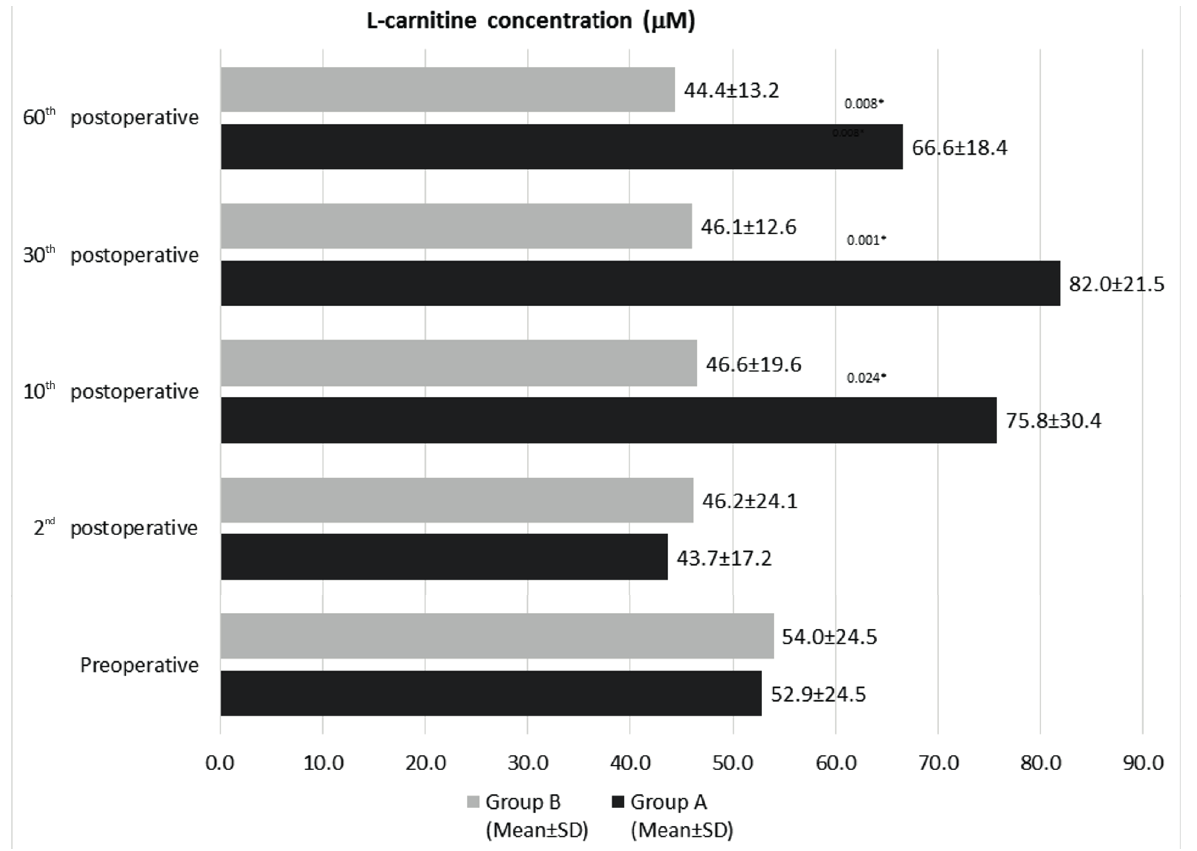
Figure 1 - Plasma concentrations of L-carnitine in all evaluated